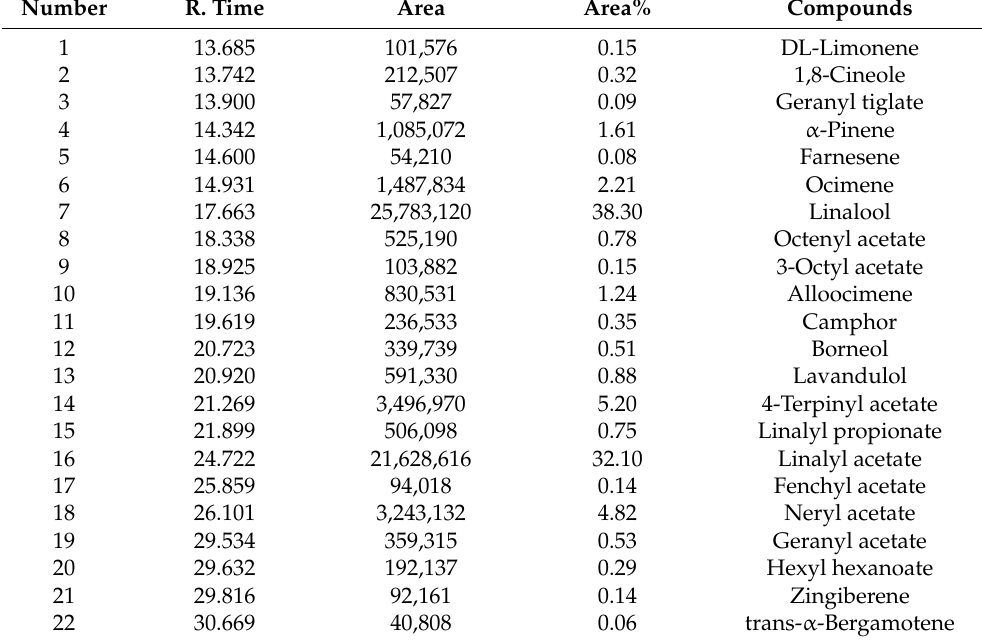
Table 2. Percentage of volatile components isolated from lavender essential